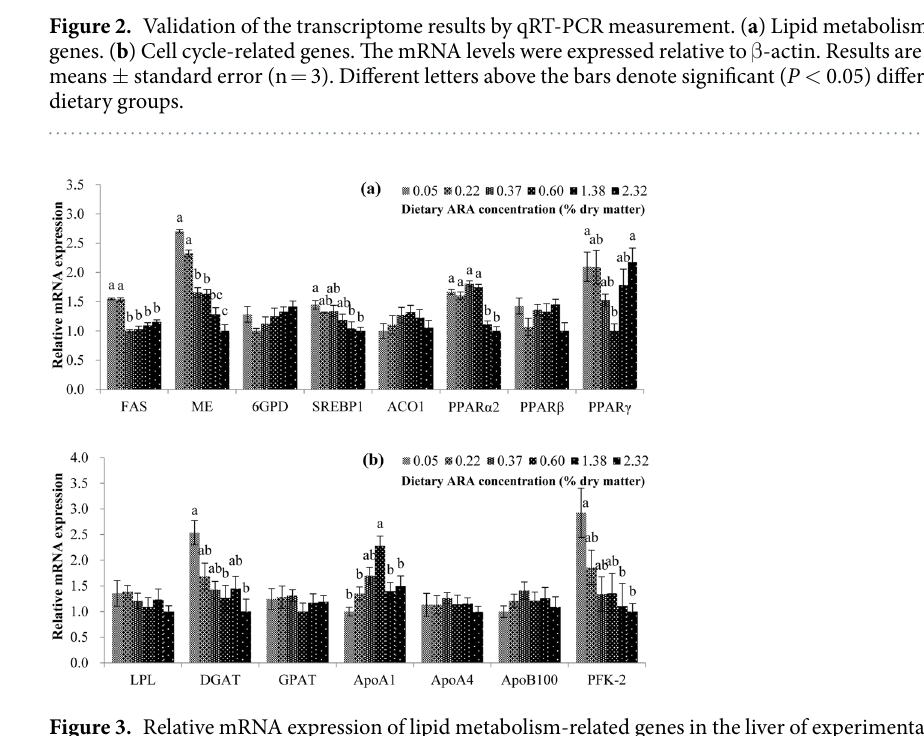
Figure 3. Relative mRNA expression of lipid metabolism-related genes in the liver of experimental fish. ( a ) Lipogenesis and β -oxidation-related genes; ( b ) Other lipid metabolism-related genes. The mRNA levels were expressed relative to β -actin. Results are expressed as means ± standard error (n = 3). Different letters above the bars denote significant ( P < 0.05) differences among dietary